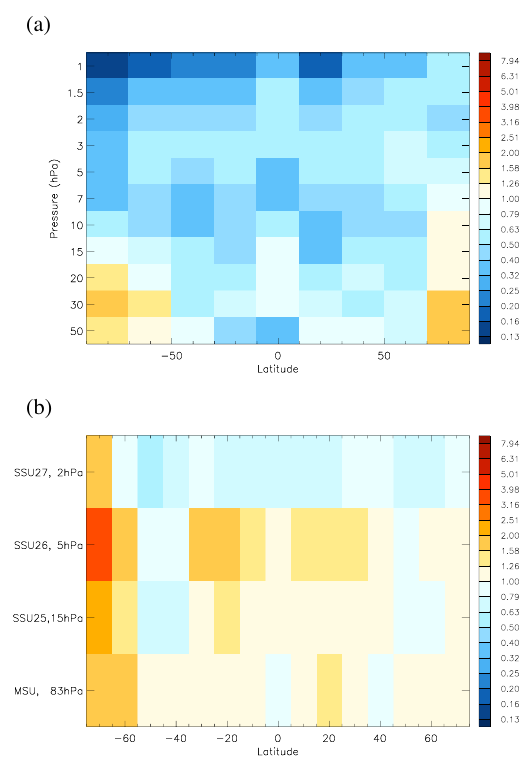
Fig. 5. Ratios of simulated to observed variances in (a) ozone mix- ing ratio and (b) MSU and SSU layer temperatures, as a function of latitude and pressure. Variances were calculated from monthly anomalies over the 1979–2005 period, and simulated variances were taken from the ALL simulations.